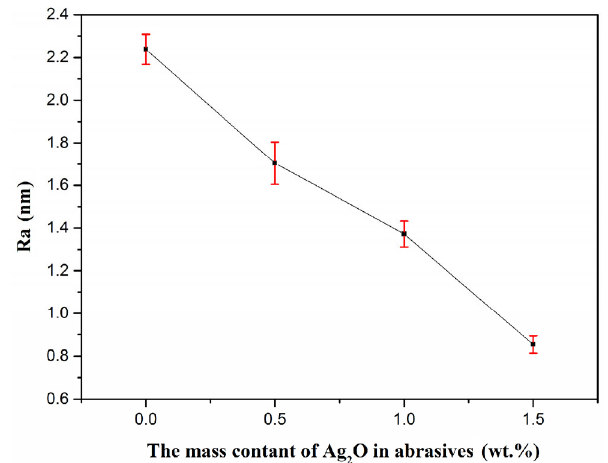
Fig. 5 The relationship between Ra and the mass content of Ag 2 O in abrasives (red line is the error bar).